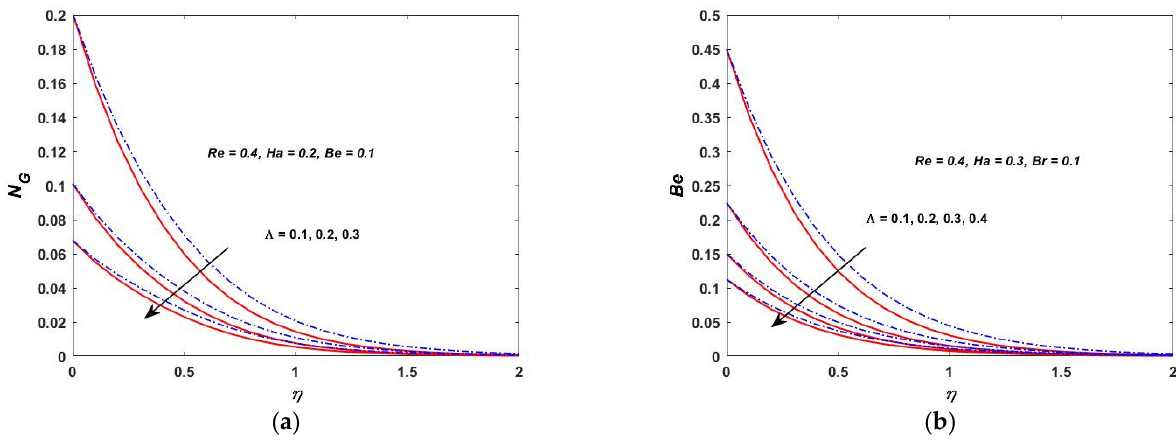
Figure 22. ( a ) Λ verses entropy 𝑁 (cid:3008) . ( b ) Λ verses Bejan (Be).